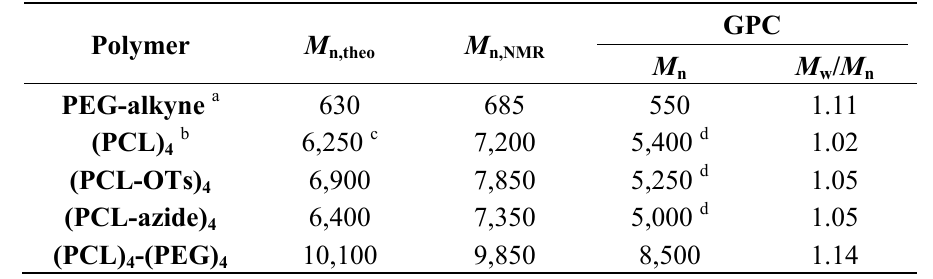
Table 1. The conditions and characterization data of the A4-B4 type star polymer and its